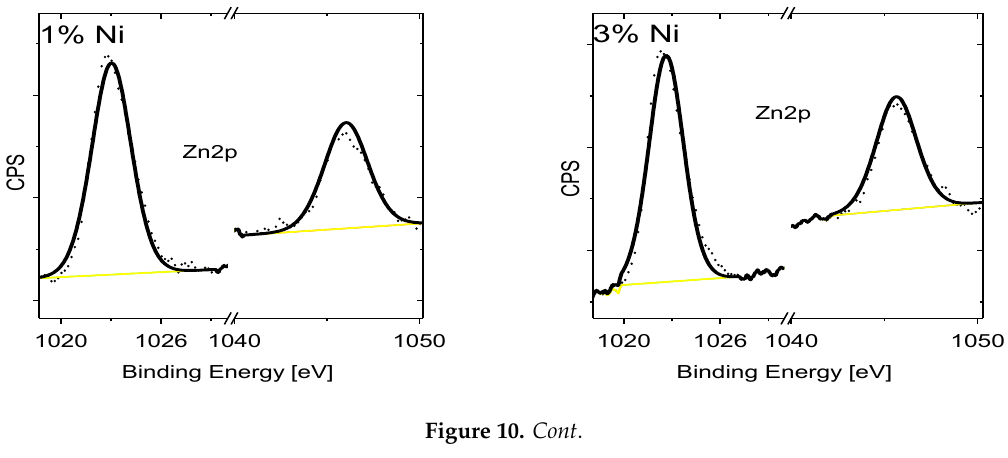
Figure 9. XPS recorded for the ZnNiO samples containing 1%, 3%, 7% and 10% Ni weight percentages. High-resolution XPS spectra are plotted for the O 1s photoelectrons.